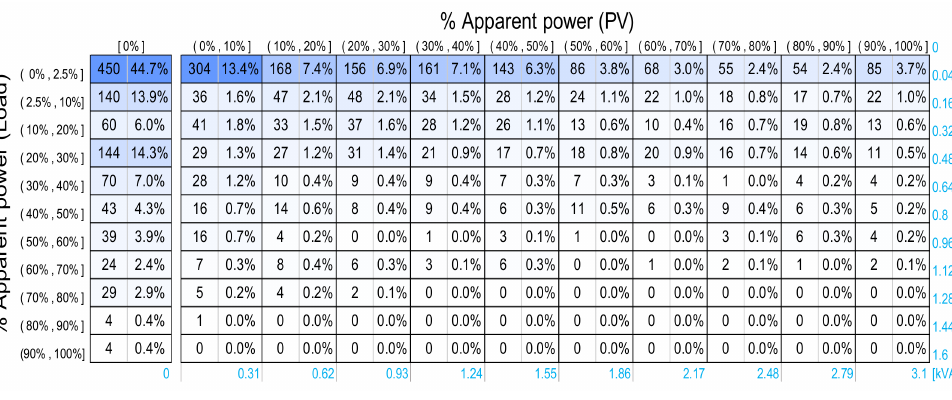
Figure 13. Frequency matrix of Phase